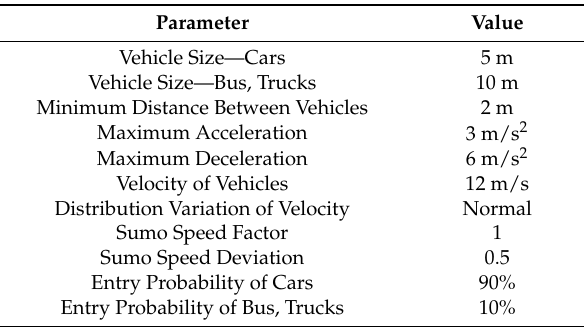
Table 4. Traffic simulation